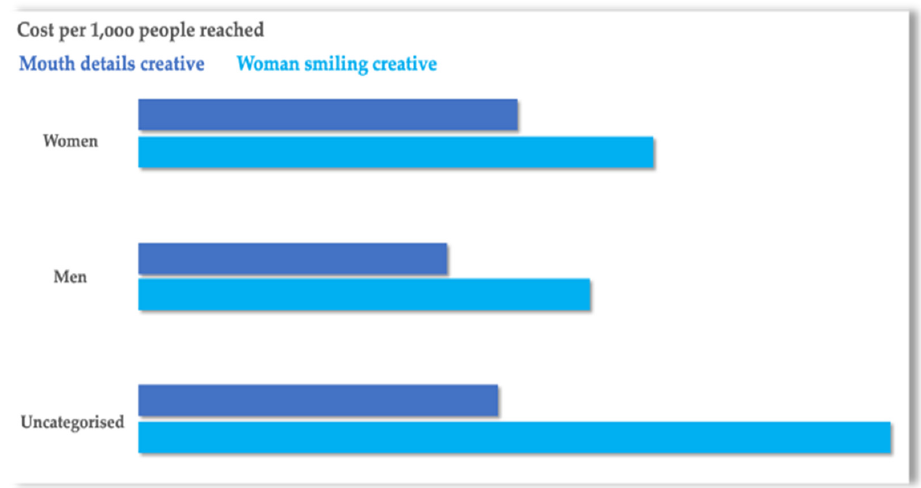
Figure 4. The cost per 1000 people reached by age.